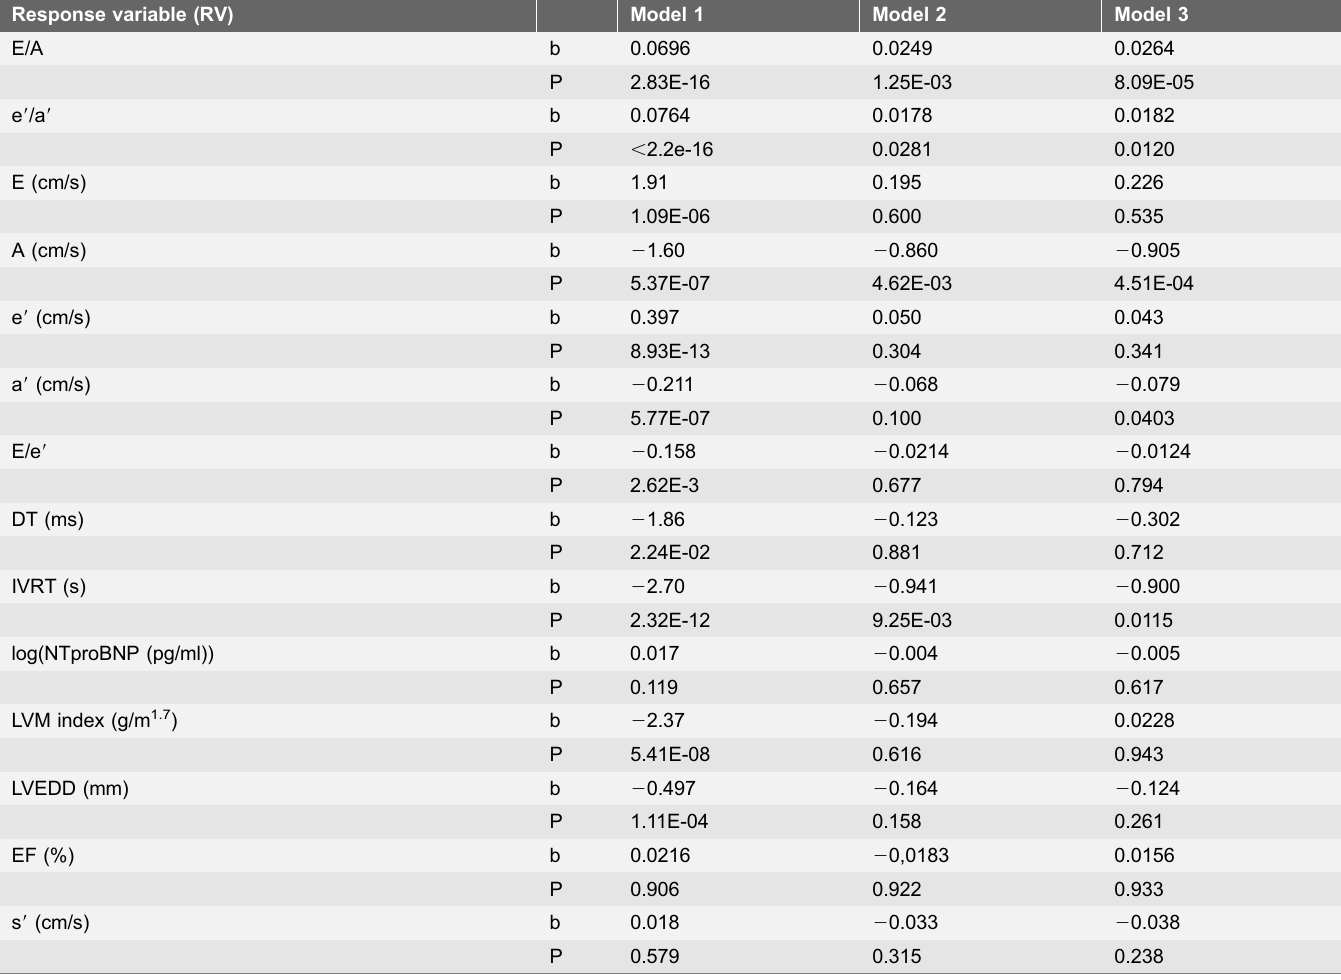
Table 2. The association of TL (kbp) with different parameters of cardiovascular function using general linear models. Response variable